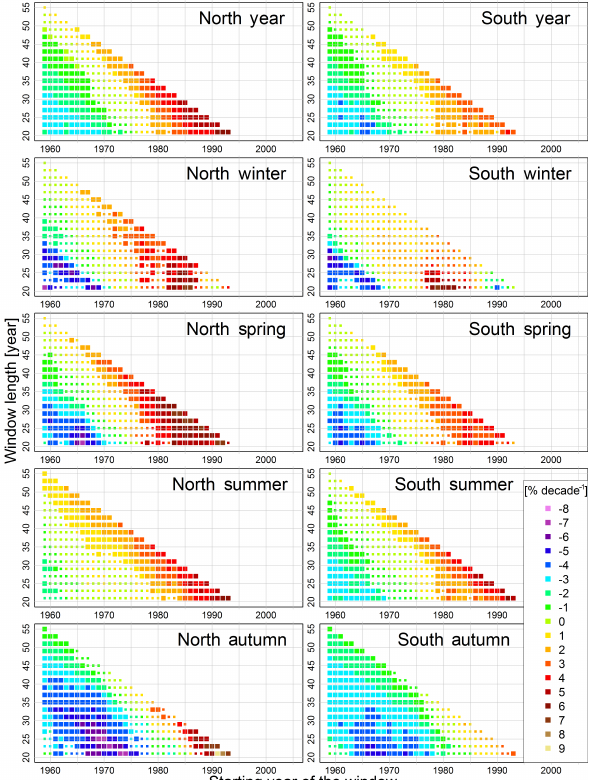
Figure 5. Running trend analysis for annual and seasonal north- ern (left column) and southern (right column) Italian SSR records obtained under all-sky conditions. The y and x axis represent the length and the first year of the period under analysis, respectively, while the colored pixels show the trend expressed in %decade − 1 with a significance level of p ≤ 0.1 (large squares) and p > 0.1 (small